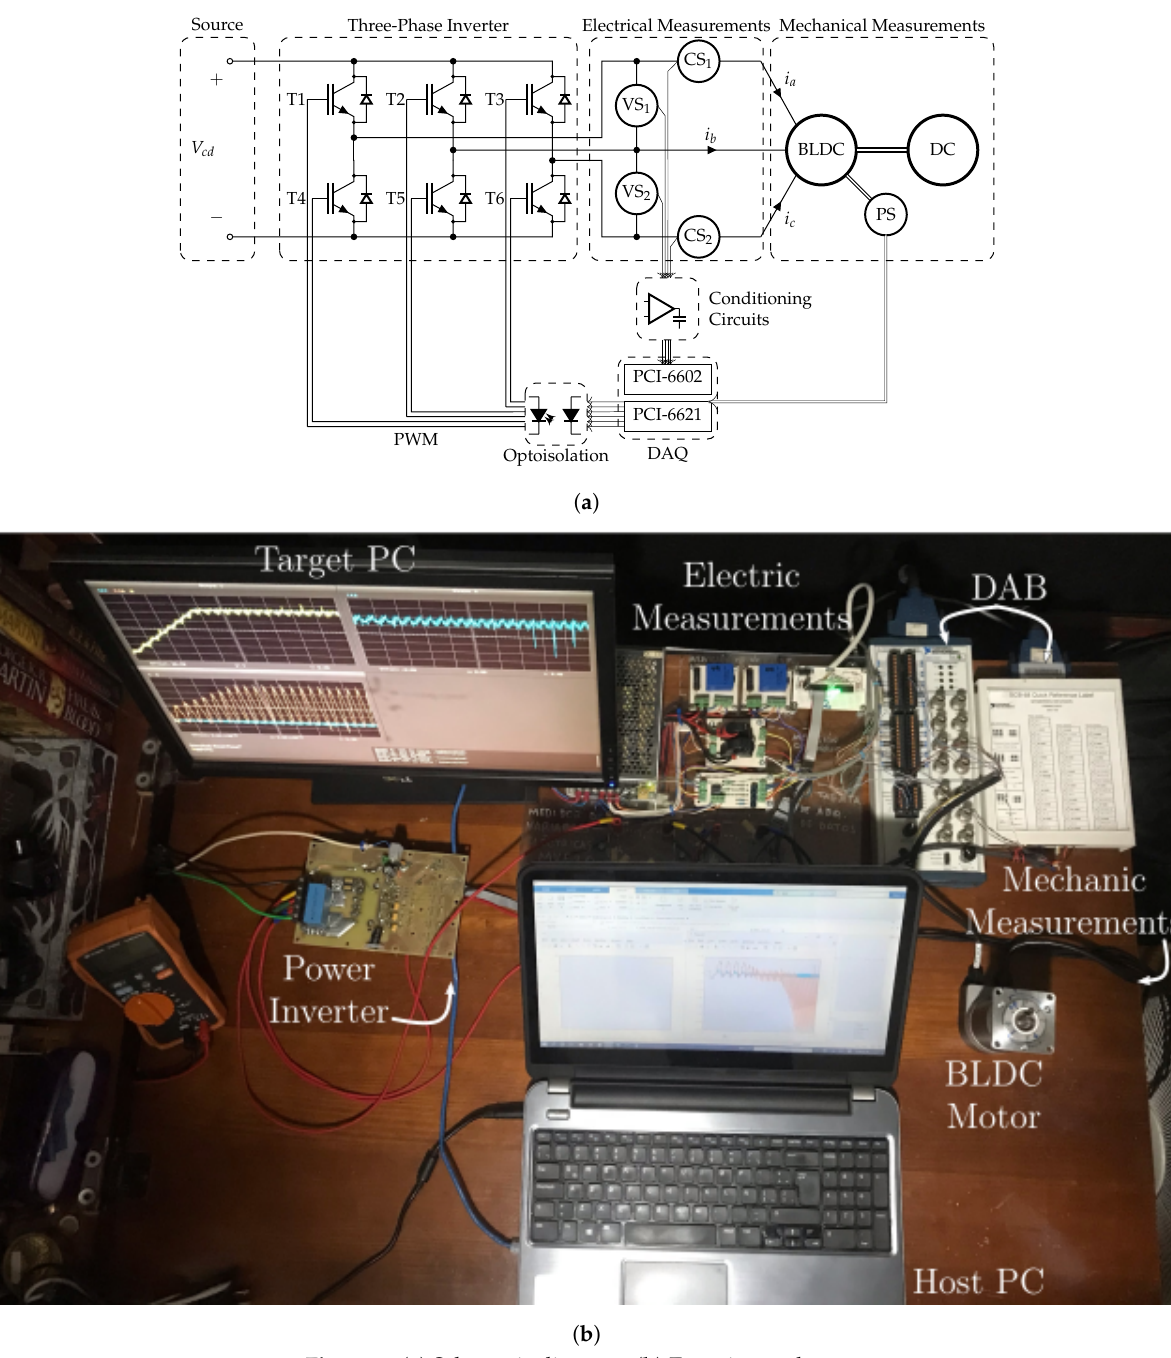
Figure 2. ( a ) Schematic diagram. ( b ) Experimental